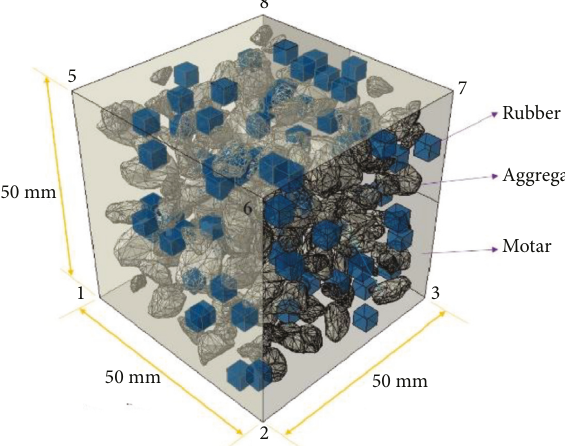
Figure 1: Test block of rubberized concrete. Table 1: Mortar parameters used in the model [26]. Figure 2: Schematic diagram of compression